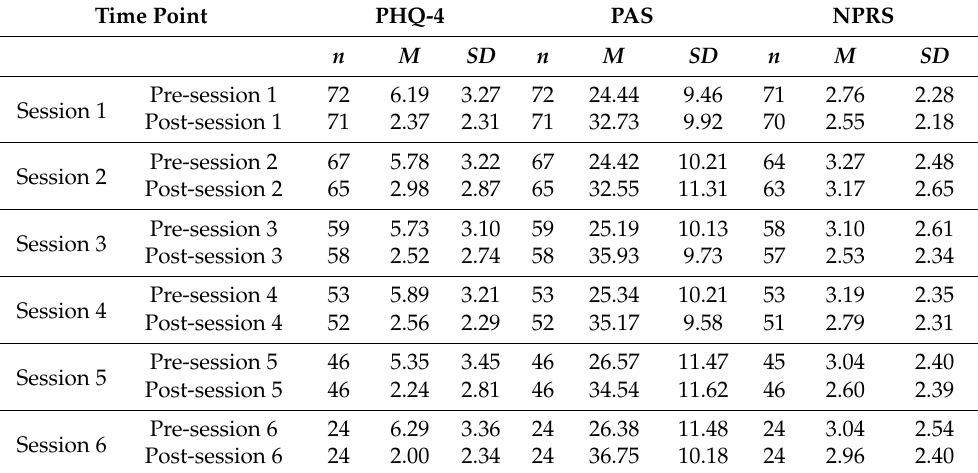
Table 2. Means and standard deviations of psychological outcomes at session assessment time